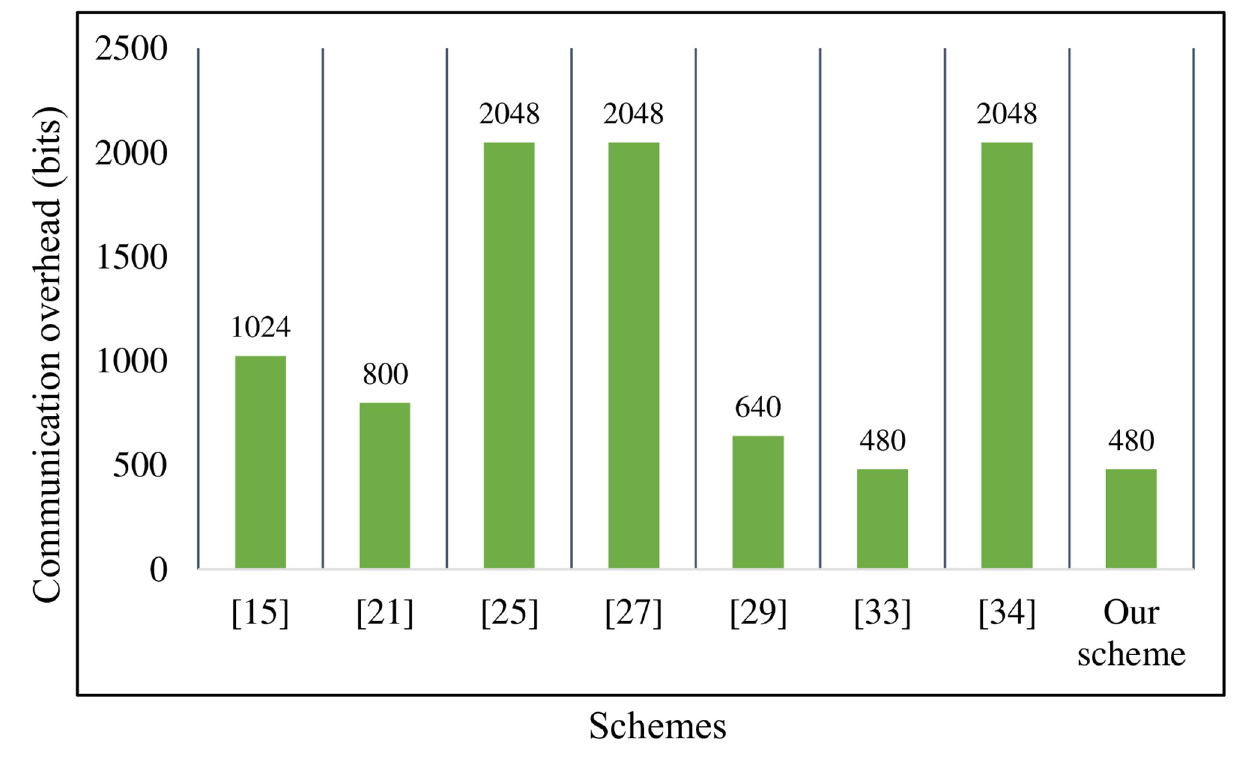
Fig 4. Communication overhead of single signatures.